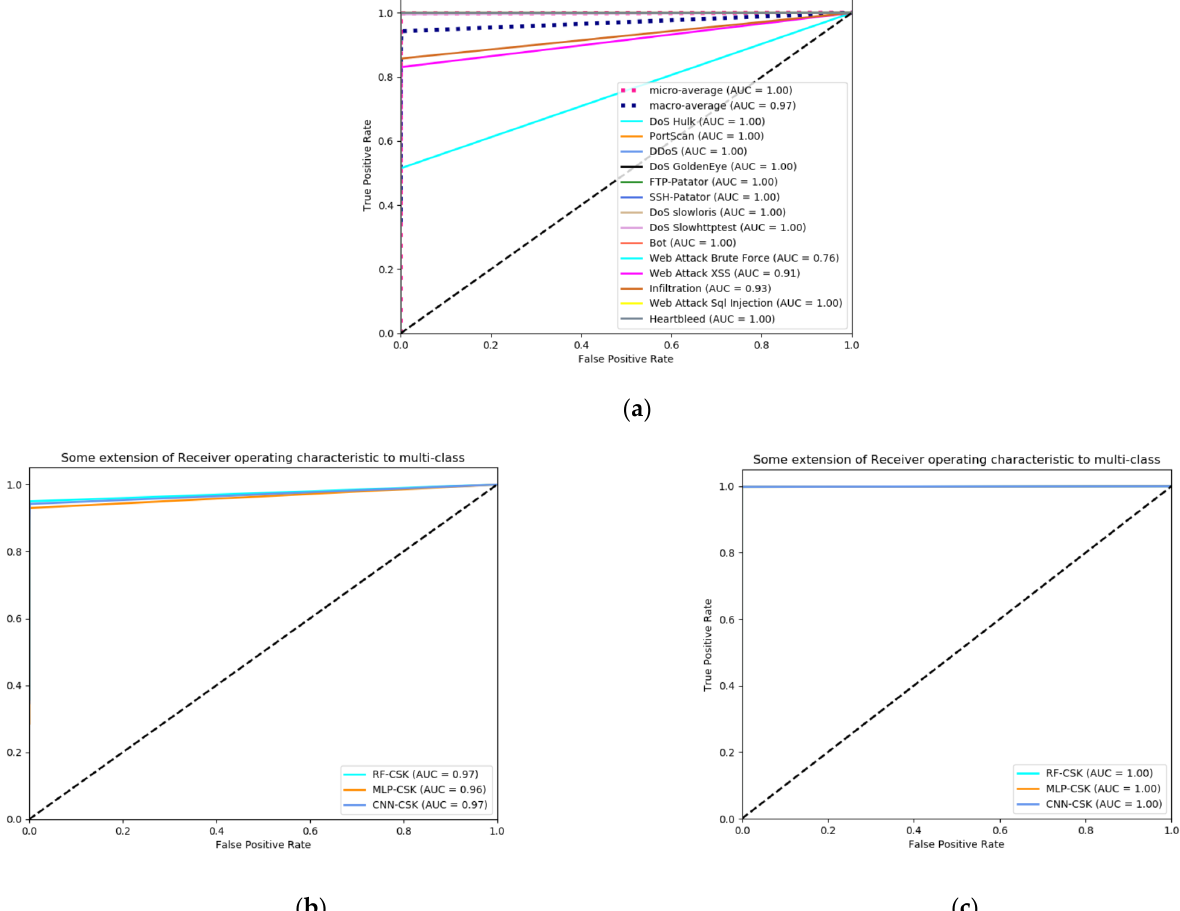
Figure 5. ROC curve of multi-classification for CICIDS2017. ( a ) 14-class; ( b ) macro; ( c ) micro.